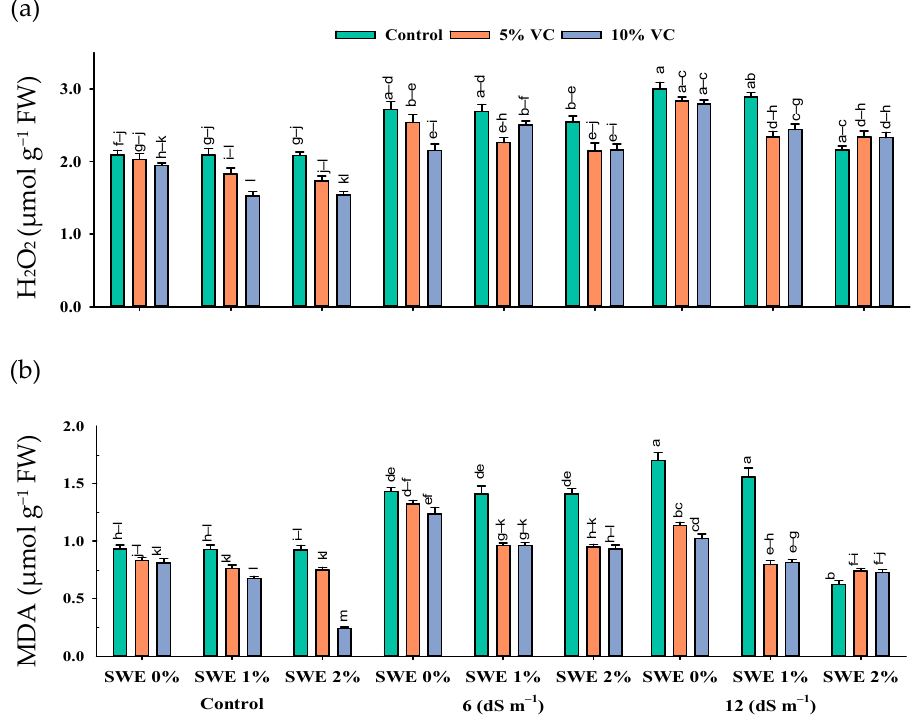
be statistically significant ( p ≤ 0.05). Salinity disturbed the ionic balance and significantly increased the accumulation of Na+ in plant parts compared to unstressed plants. While it decreased the K + concentration and K + /Na + ratio in maize shoots and roots, the highest reduction in K + concentration was observed in severe salinity.